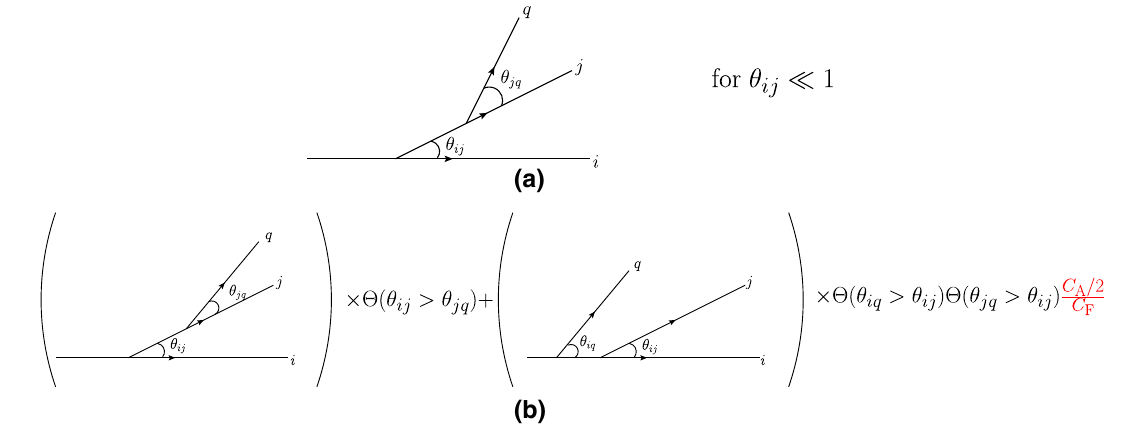
Fig. 4 Diagram a is generated using our dipole shower, after partition- ing. This topology is where the N − 2 c error emerges. Diagram b repre- sents the re-arrangements of a that can be made in the limit θ ij (cid:3) 1.